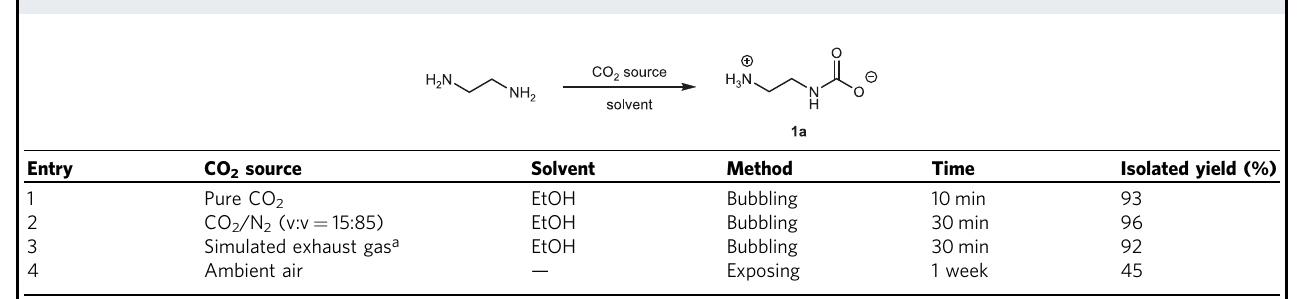
Table 1 Synthesis and isolation of 1a from various CO 2